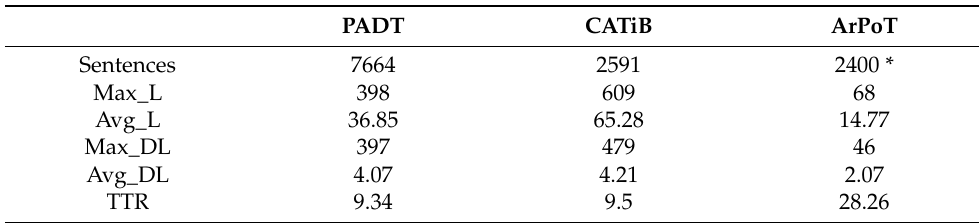
Table 5. Number of sentences (Sentences), maximum sentence length (Max_L), average sentence length (Avg_L), maximum dependencies length (Max_DL), average dependencies length (Avg_DL), and TTR type–token ratio